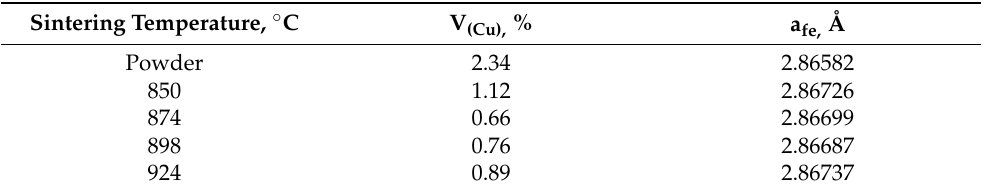
Table 5. Volume fractions of (Cu) and lattice parameters of ferrite in the powder and sintered samples. Sintering Temperature, ◦ C